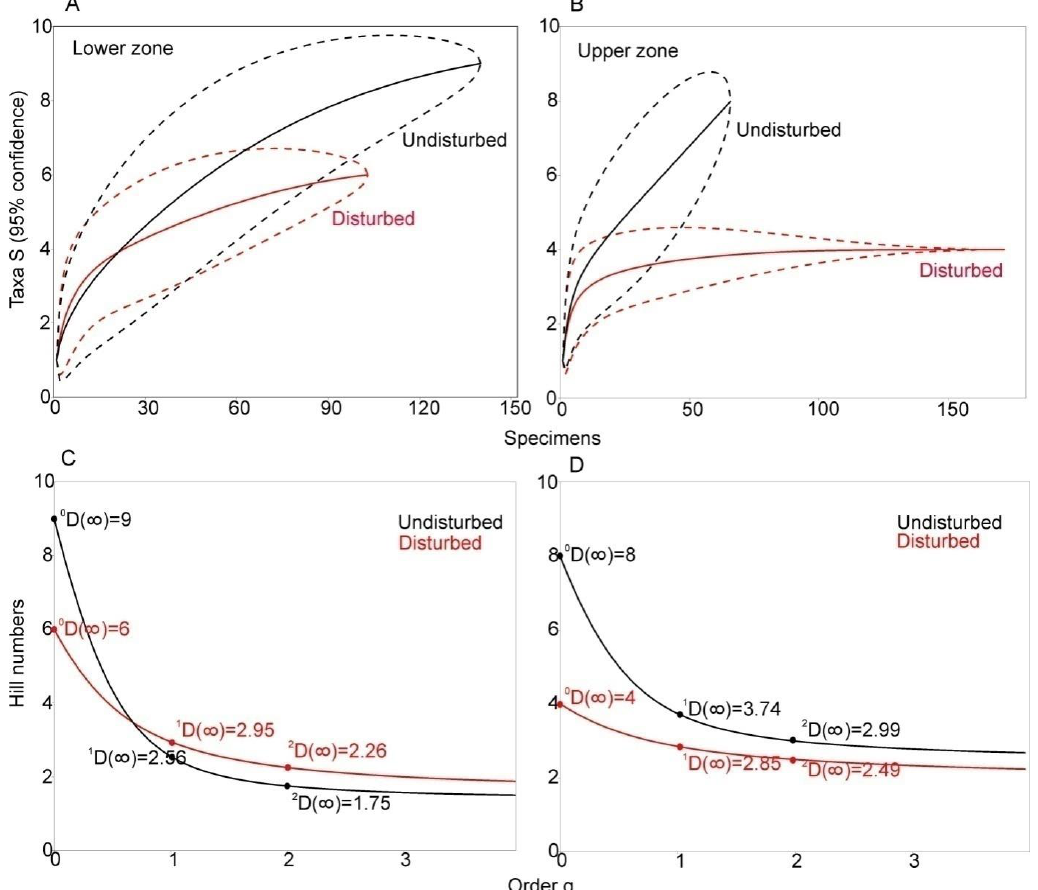
Figure 6. Rarefaction curves with 95% confidence intervals for species richness of bats ( A, B ) and diversity profile curve plotting Hill numbers ( C, D ) for the undisturbed and disturbed coniferous forests of the lower and upper forest zone in the Polish Tatra Mountains, 2016 – 2020.